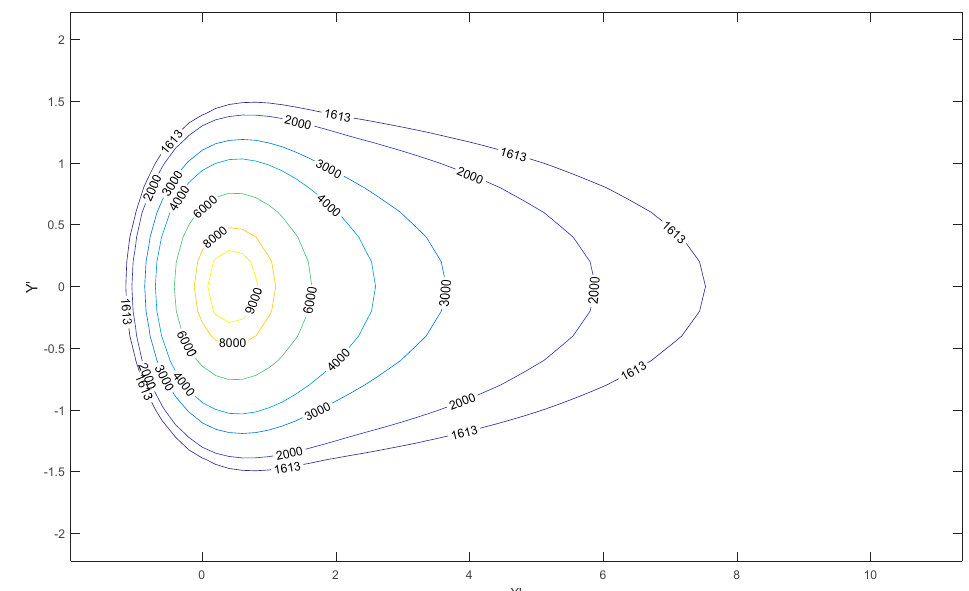
Figure A3. Melt pool temperature contour at top view for In718 with a laser power of 100 W, scanning speed of 1 mm/s, laser spot radius of 50 μ m and absorptivity at room temperature.